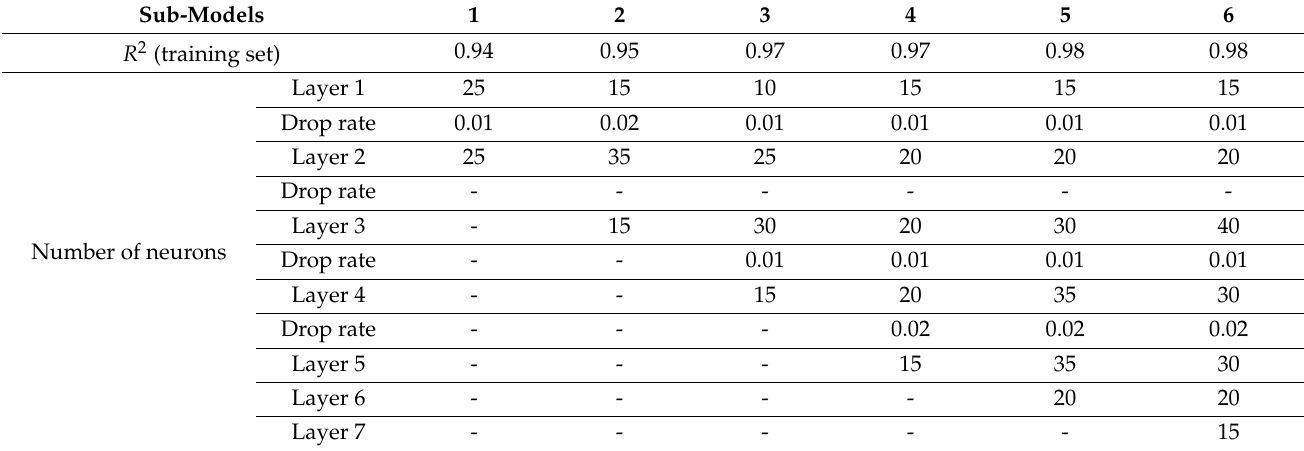
Table 2. Characteristics of the basic models.